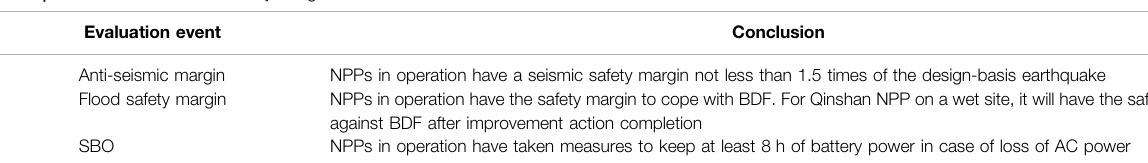
TABLE 2 | General conclusions of safety margin evaluation for BDBEE.